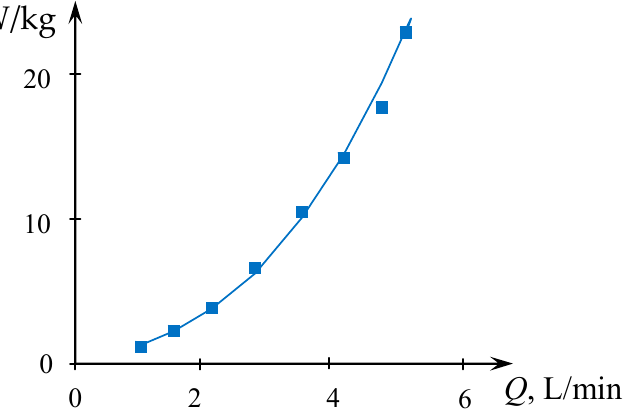
2 973 0 1644 Q . . ( Q is in L/min, ε is in kW/kg).